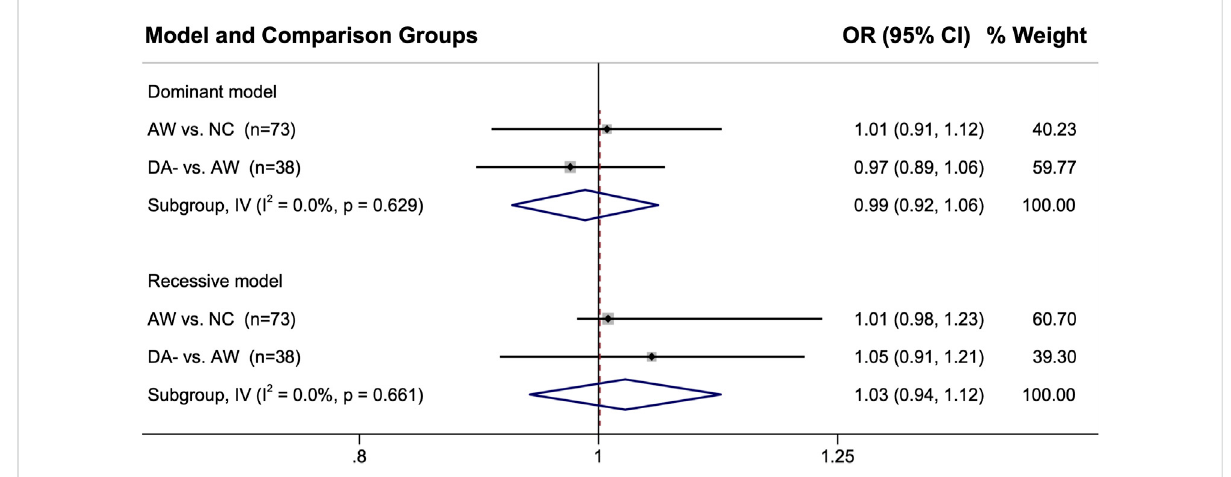
FIGURE 4 Comparison of the genotype distributions between control groups from the studies in which two control groups were used. When single nucleotide polymorphisms were reported, either the dominant model or the recessive model was used for that particular genetic marker. Abbreviations: AW, asymptomatic exposed worker; 95% CI, 95% con fi dence interval; DA-, diisocyanate asthma negative worker with respiratory symptoms; I 2 , heterogeneity statistic; IV, inverse-variance statistical model; n, number of genetic marker comparisons; NC, normal non- exposed healthy control; OR, odds